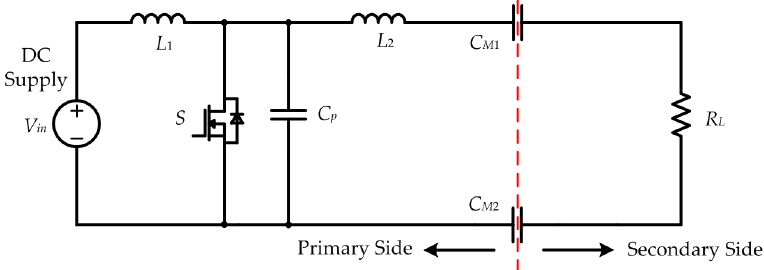
Figure 14. Circuit topology of a CPT system based on class E converter.